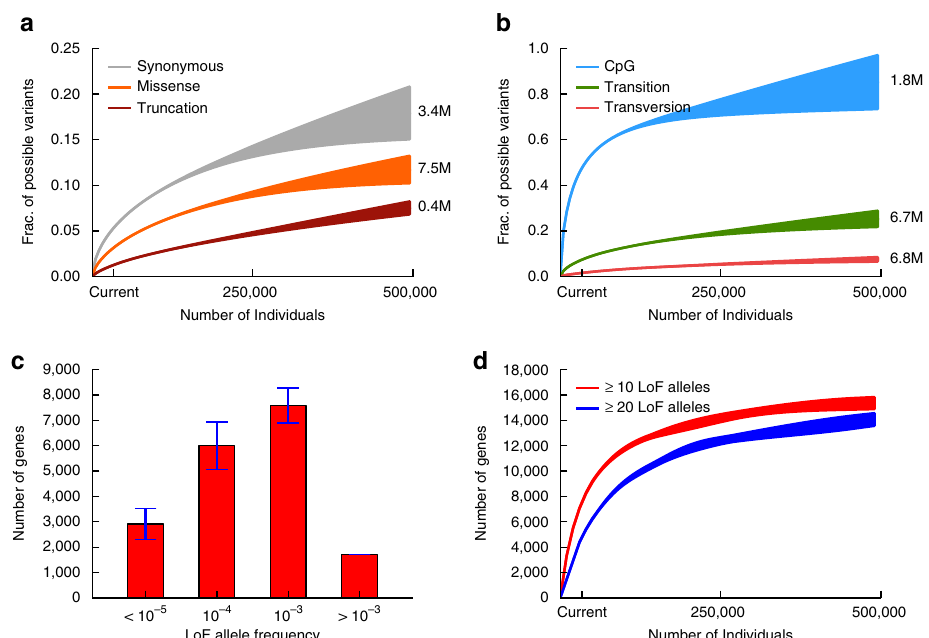
Figure 1 | Predictions for the number of unique variants in 500K individuals. We trained UnseenEst on the U.S. Census-matched ExAC cohort (‘current’) and predicted the number of unique variants we expect to find in up to 500K individuals. The number of unique variants in the cohort were estimated for synonymous, missense and LoF variants in ( a ), and for CpGs, transitions and transversions in ( b ). The shaded regions correspond to one standard deviation around the estimates. ( c ) A gene is classified as LoF on a given allele if that allele contains at least one variant that introduces a stop codon, disrupts a splice donor/receptor site or disrupts the reading frame. Genes are partitioned into bins based on their LoF allele frequencies: o 10 (cid:2) 5 , 10 (cid:2) 5 –10 (cid:2) 4 , 10 (cid:2) 4 –10 (cid:2) 3 and 4 10 (cid:2) 3 . The y axis indicates the number of genes with LoF allele frequency belonging to each bin. Error bars correspond to one standard deviation. ( d ) Estimated number of genes with at least 10 and 20 LoF